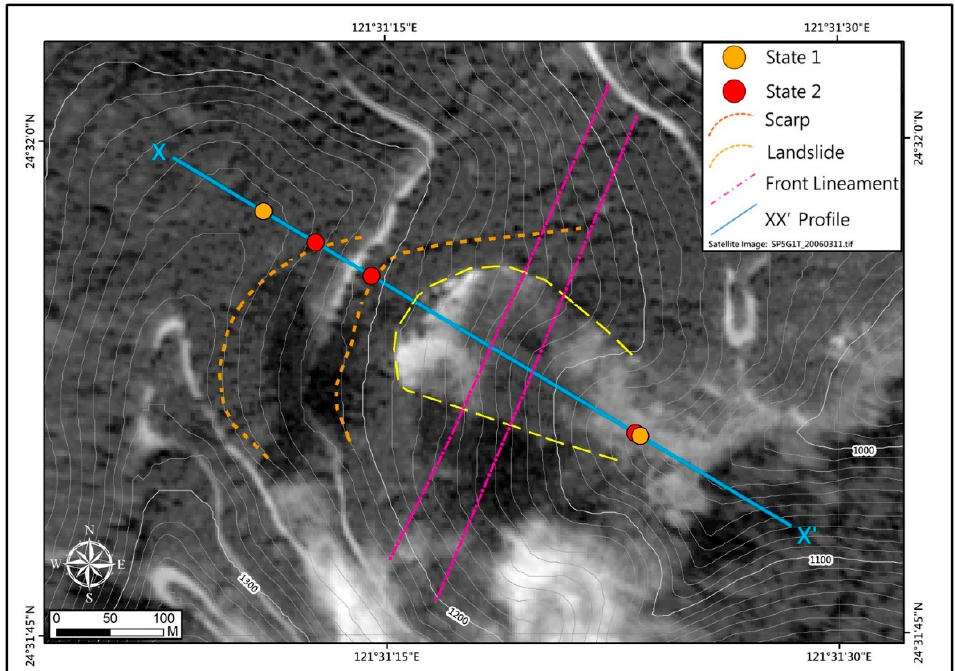
Figure 18. The mapped scarps of SPOT5 image and the crest and toe points of the potential sliding surface resulted from numerical analysis of profile X-X’ (WGS 84 coordinates). Points marked as state 2 indicated results of the slope model with shear zone (with geological structures), and points marked as state 1 indicated results of numerical analysis of slope model without geological structures.